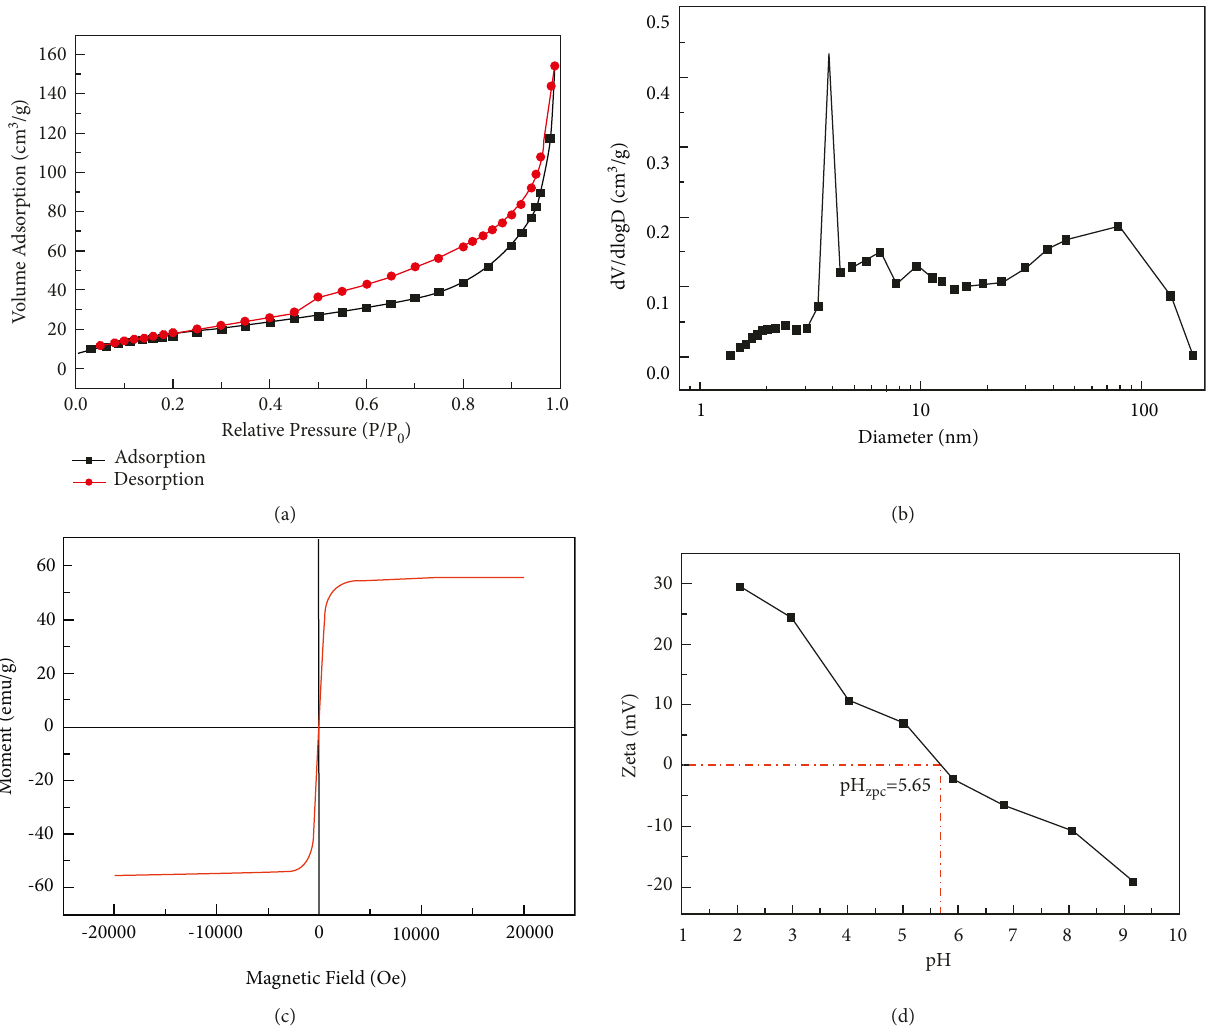
Figure 3: (a, b) N 2 adsorption-desorption curves and the pore size distribution curve of TGOM; (c) magnetization curve of TGOM; (d) zeta potential of